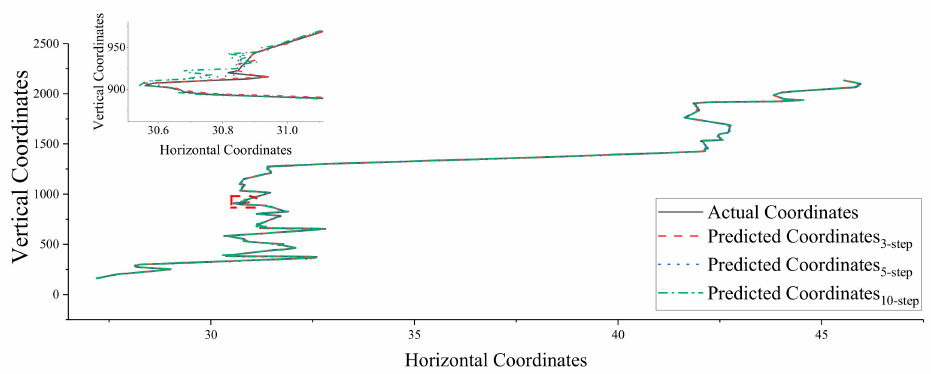
Figure 6. Figure of multistep trajectory prediction